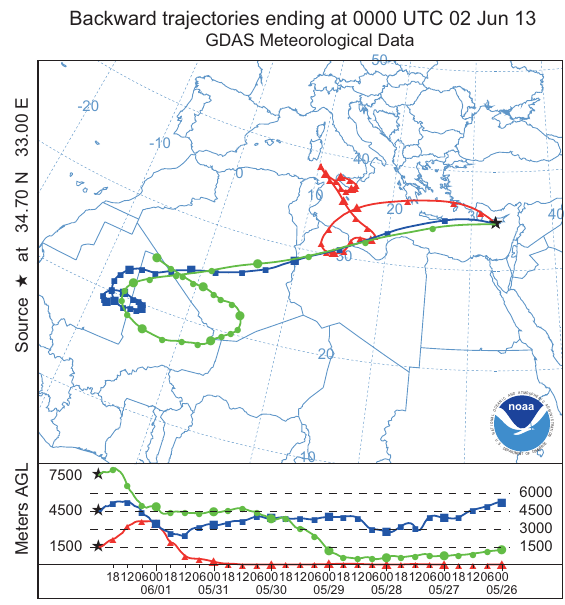
Figure 7. HYSPLIT 7-day backward trajectories arriving within the dust layer over Limassol, Cyprus, at 1500 (red), 4500 (blue), and 7500m height (green) on 2 June 2013,